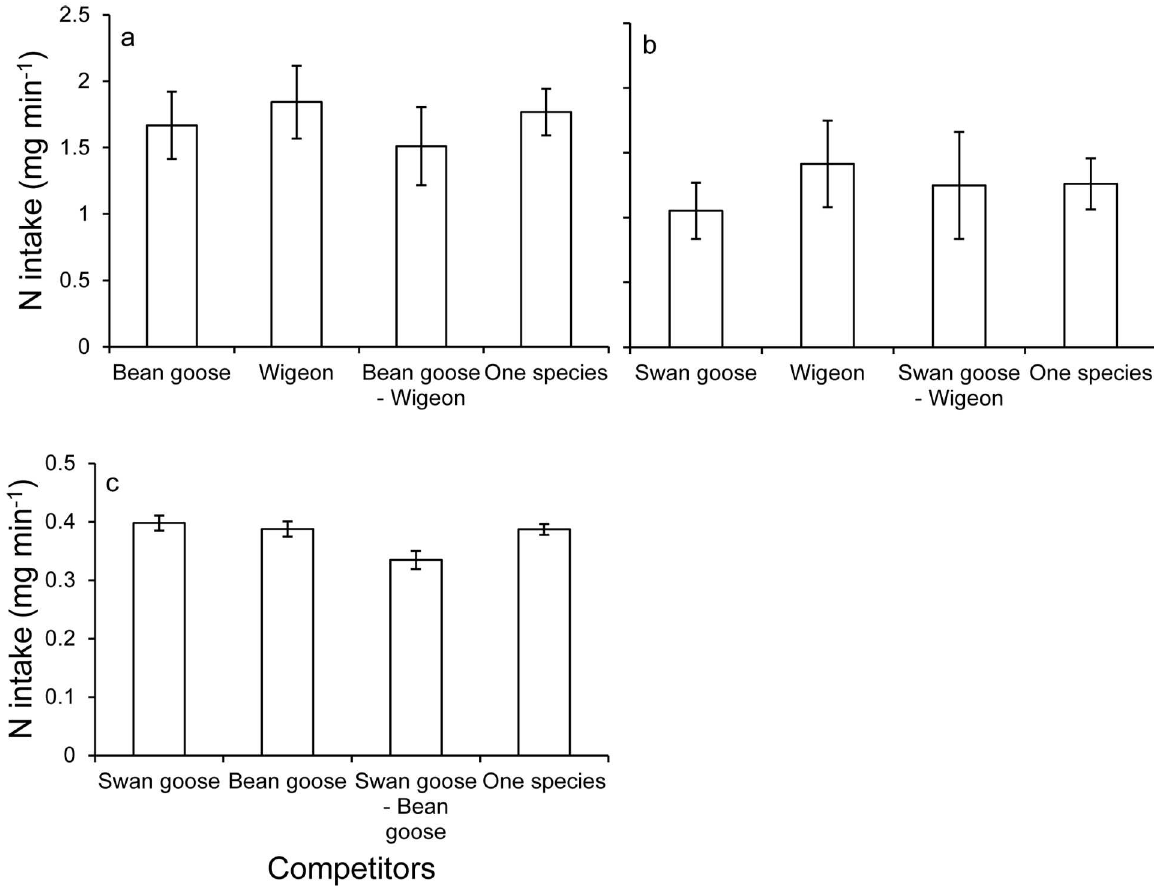
Fig 6. Mean nitrogen intake ( ± 95% CI) with differently sized competitors. a: swan goose, b: bean goose; c: wigeon. Letters represent the results of the Tukey post-hoc test, indicatingdifferences in nitrogenintake among different species